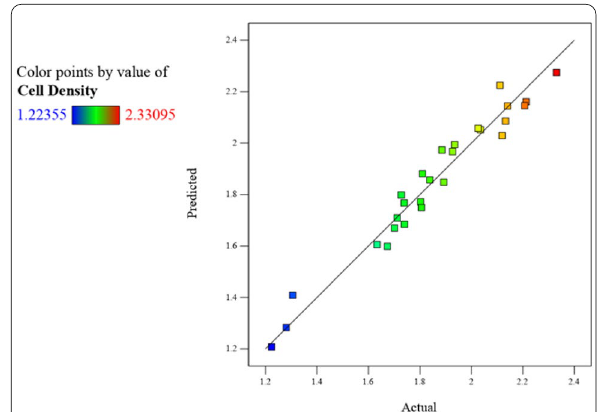
Fig. 1 Graphical representation of the minimal difference between the actual (straight line) and predicted responses (squares) for the Box–Behnken design to obtain high cell